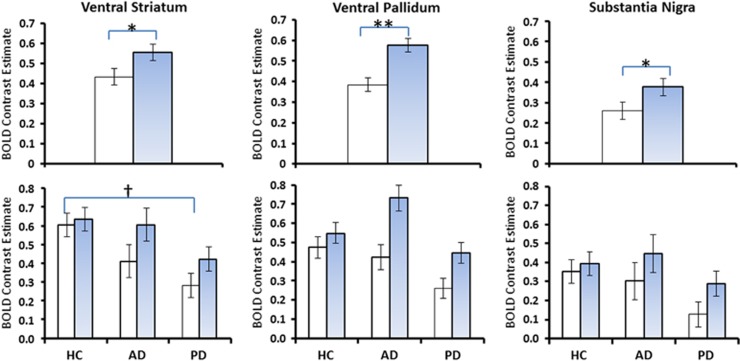
ROI response during the MID task: mean reward-neutral anticipation BOLD contrast estimate for both the placebo and the GSK598809 sessions. White bars represent the placebo session, whereas light gray/blue (when in color) represent the GSK598809 session. Histograms on the top show the main effect of drug within each ROI (*p<0.01, **p<0.001), whereas histograms below show the BOLD contrast estimates for the placebo and GSK598809 sessions for each group separately (†significant effect of group at p<0.01 in the placebo condition only). Error bars indicate within-subject SEM (Cousineau and O’Brien, 2014) suitable for assessing drug rather than group effects. A full color version of this figure is available at the Neuropsychopharmacology journal online.